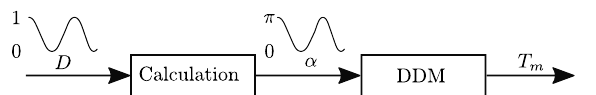
Figure 5. Schematic of open loop control for PSDS (equal for Version 1 and Version 2).